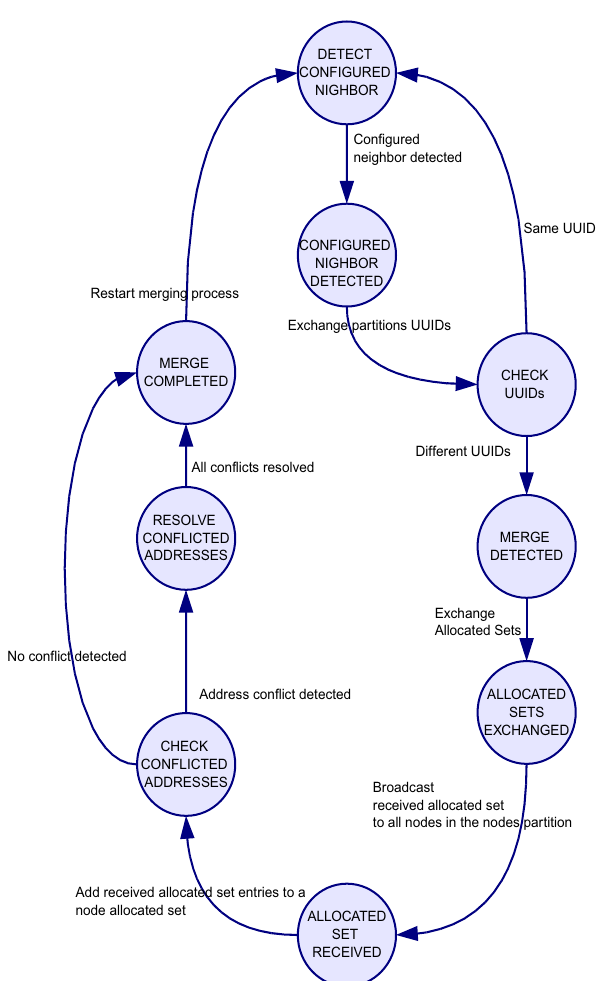
Figure 3. State diagram of the merging process of MANETconf